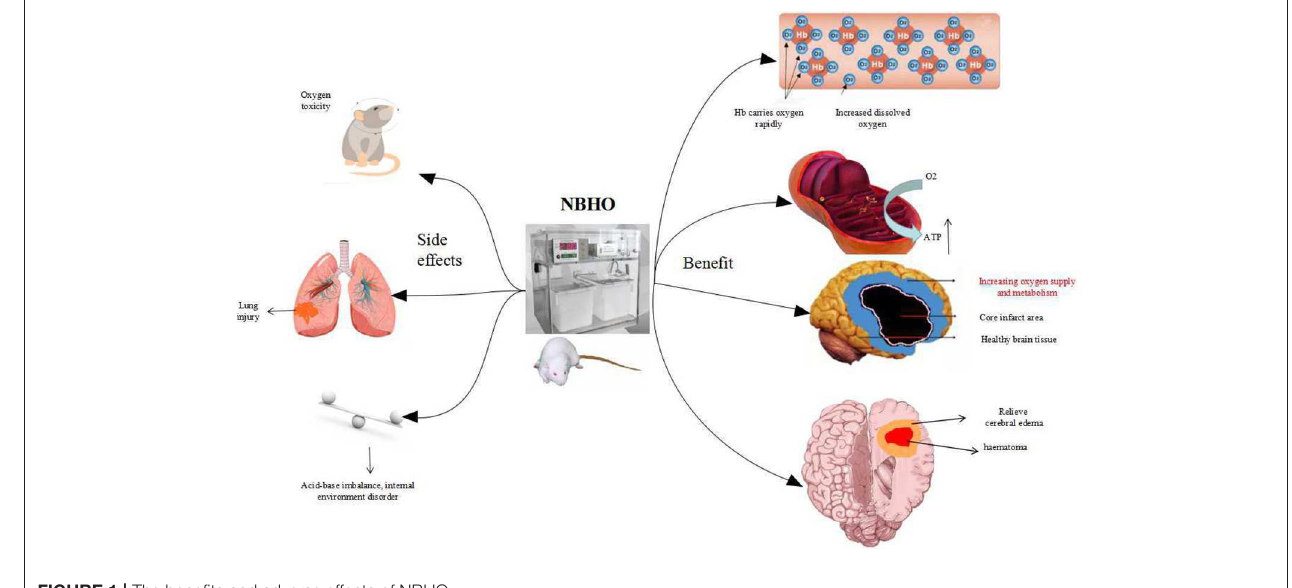
FIGURE 1 | The benefits and adverse effects of NBHO.